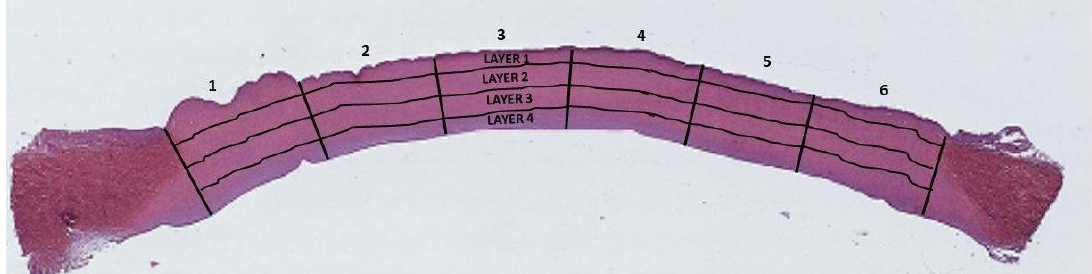
Figure 3. Cross-section of hematoxylin-eosin stained porcine cornea. The black lines indicate the regions into which the corneas are subdivided for performing the measurements. The grid outline of the 6 radial frames along the minor axis and the 4 layers along the major axis, thus obtaining 24 ROIs per corneal slides. The entire stromal thickness has been analyzed in each section of the three corneal populations considered. The stroma located at the top of the corneal section represents the anterior part of the cornea; the inferior part represents the inner (posterior) stroma of the cornea.